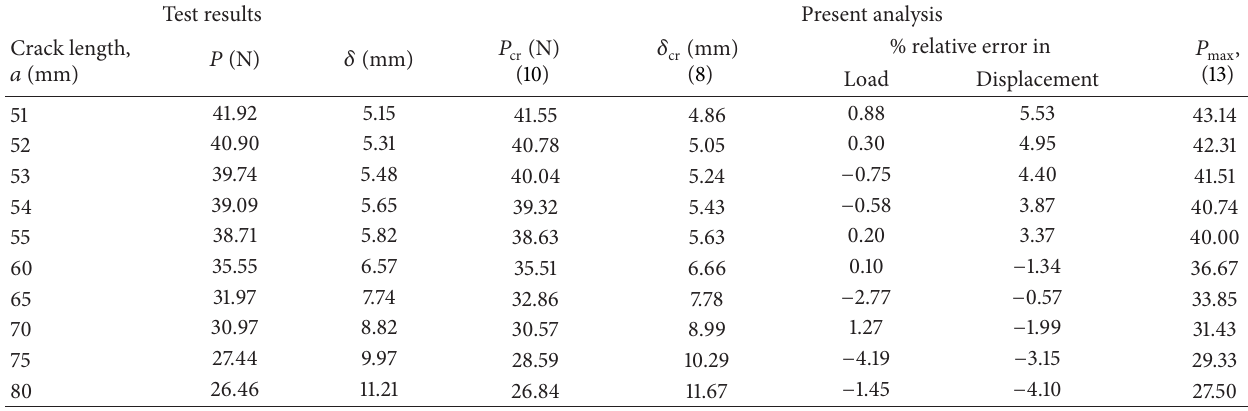
Table 2: Critical load 𝑃 and corresponding displacement 𝛿 for the measured crack length of a DCB specimen made of unidirectional cr cr carbon/epoxy composite. Test results Present